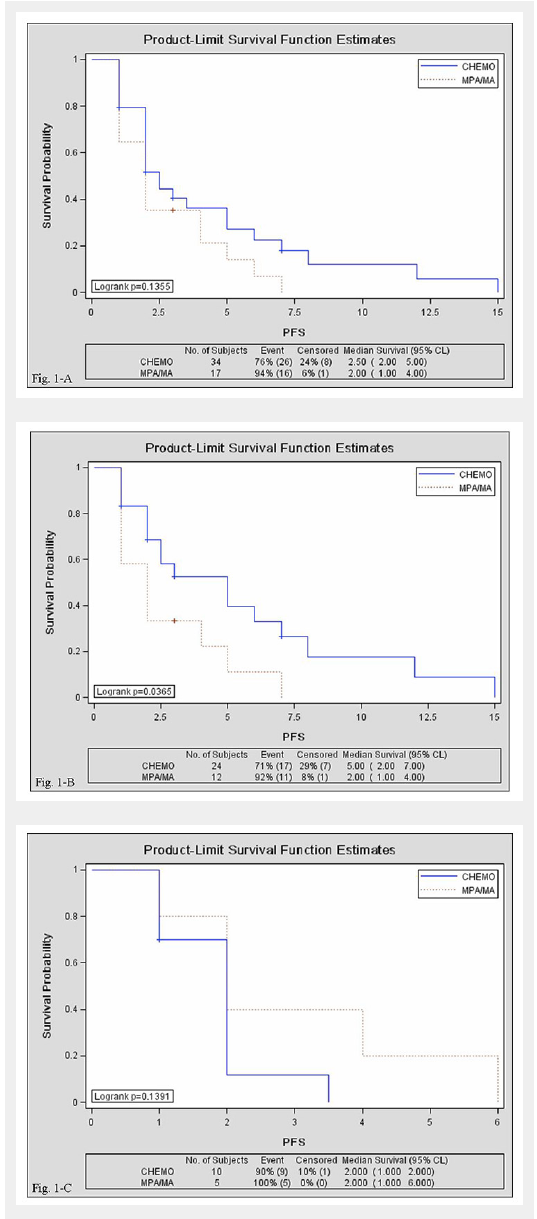
Kaplan–Meier curves for progression-free survival in the MPA/MA and chemotherapy groups. A: overall; B: 1–6 lines of salvage therapy; C: ≥7 lines of salvage therapy. CHEMO, chemotherapy group; MPA/MA, medroxyprogesterone acetate/megestrol acetate group; PFS, progression-free survival; CI, confidence